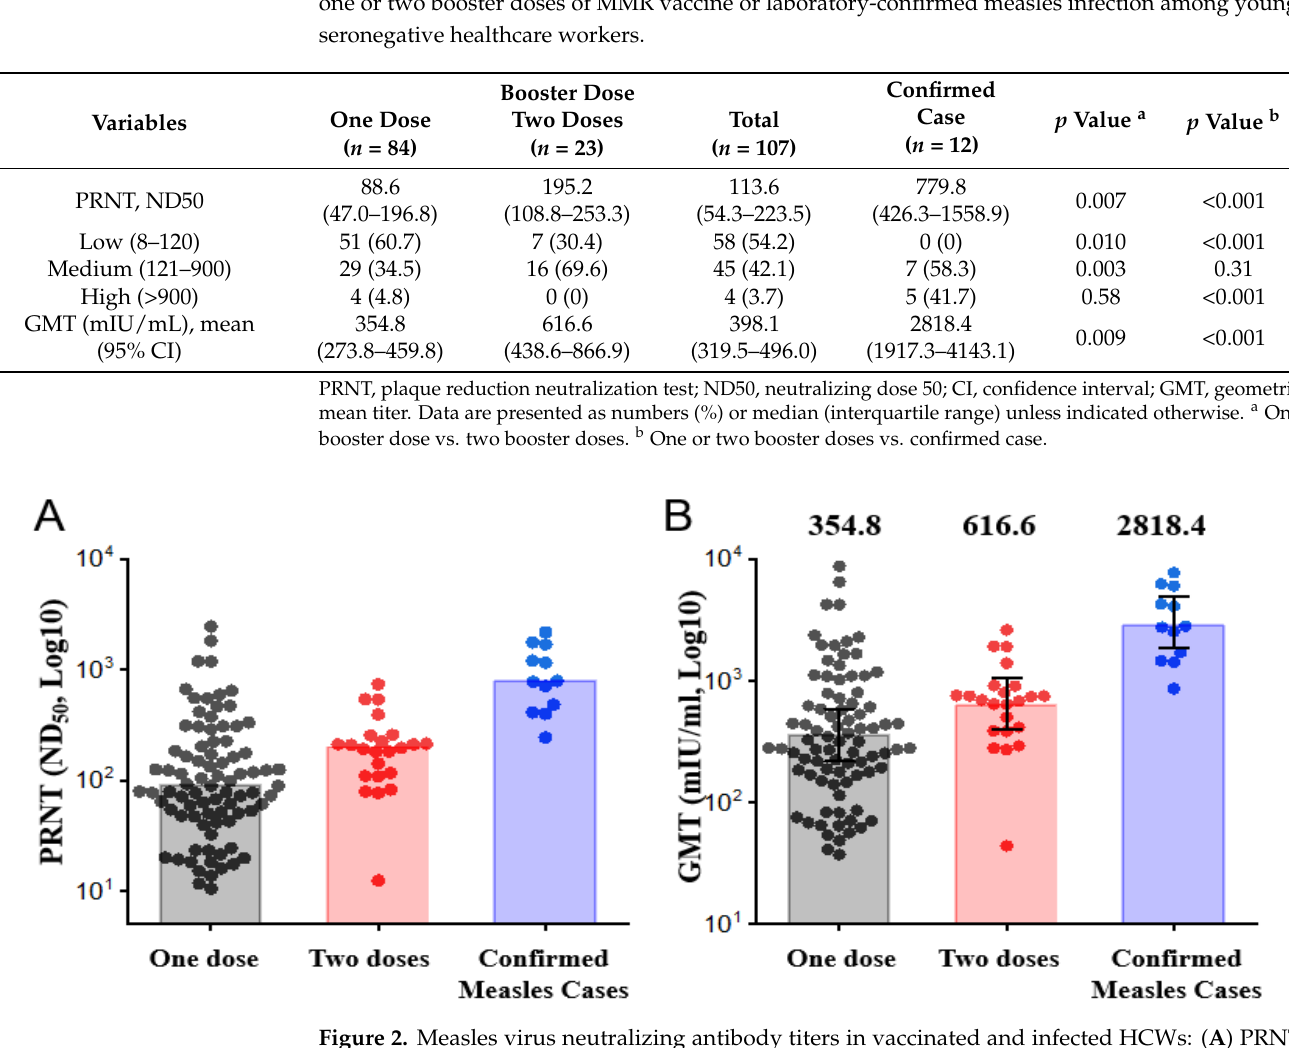
Figure 2. Measles virus neutralizing antibody titers in vaccinated and infected HCWs: ( A ) PRNT ND50 values of one or two MMR doses and confirmed measles cases are represented by a dot plot and bars. The heights of the bars indicate the median value. ( B ) Individual neutralizing antibody titers are shown as a dot plot, and the bars represent the geometric mean titers, with error bars that show 95% confidence intervals. The values above the bars are the geometric mean titers.